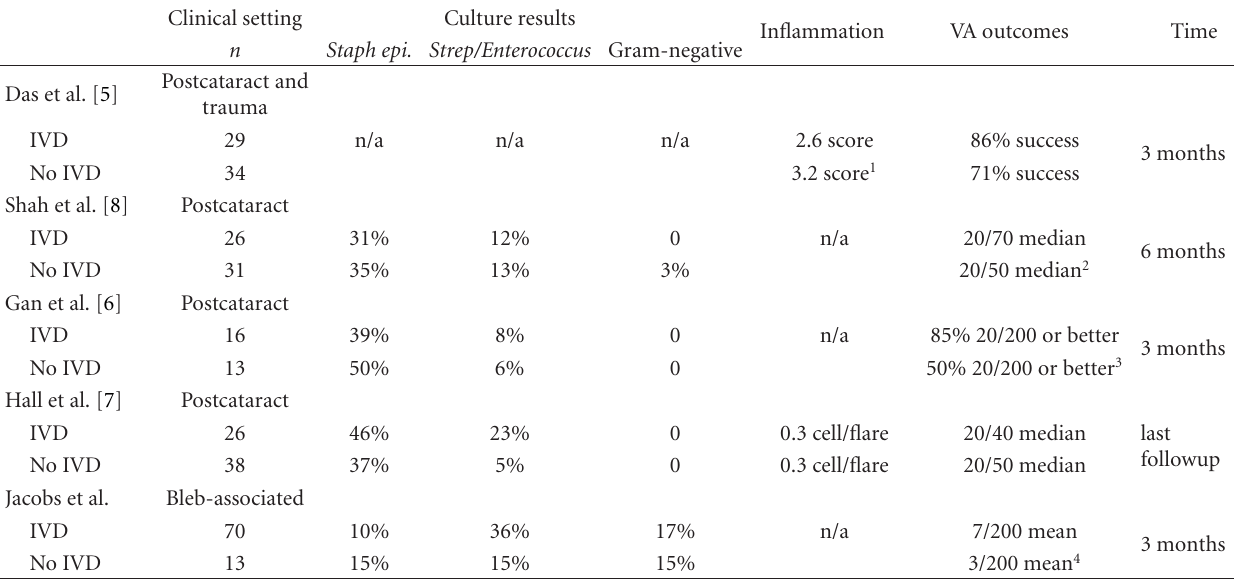
Table 5: Comparative studies of IVD for bacterial endophthalmitis.